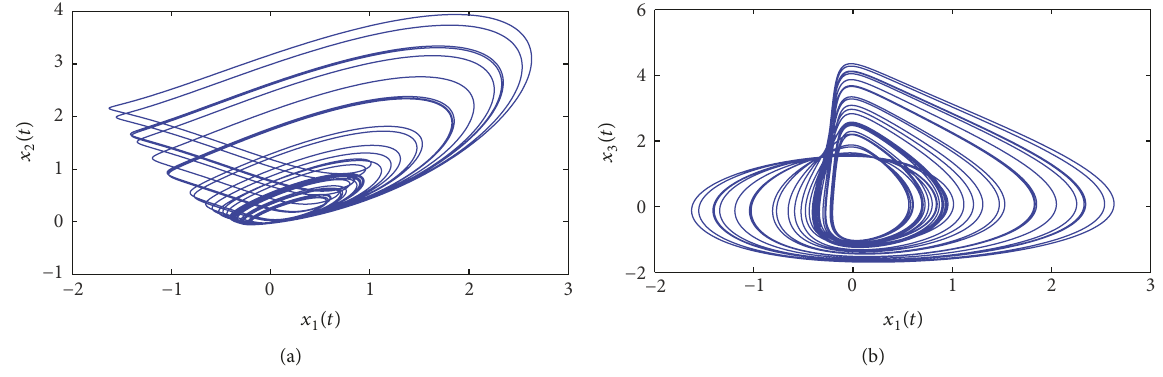
Figure 1: A chaotic attractor in system (2) for 𝑞 = 0.96 .